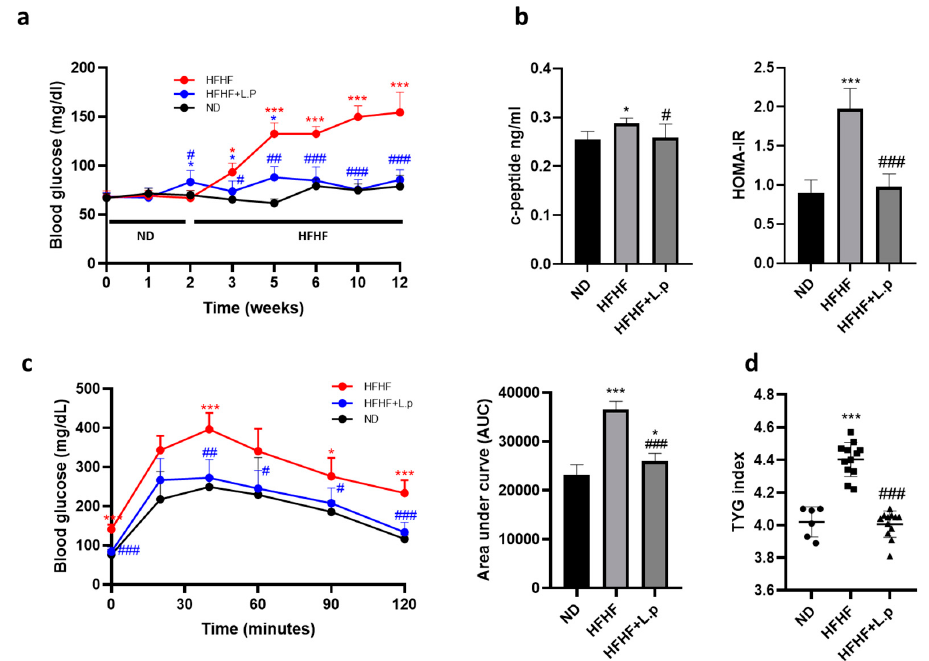
Figure 2. The effect of L.p DSM20174 supplementation on glucose homeostasis and TYG index. ( a ) Fasting blood glucose measured at several time points during the experimental procedure. ( b ) Serum c-peptide and HOMA-IR index. ( c ) Blood glucose levels in response to glucose tolerance test (GTT). Effect on area under de curve (AUC). ( d ) Triglyceride glucose (TYG) index. Data are expressed as mean ± SEM. * p < 0.05, *** p < 0.001 vs. ND; # p < 0.05, ## p < 0.01, ### p < 0.001 vs. HFHF.